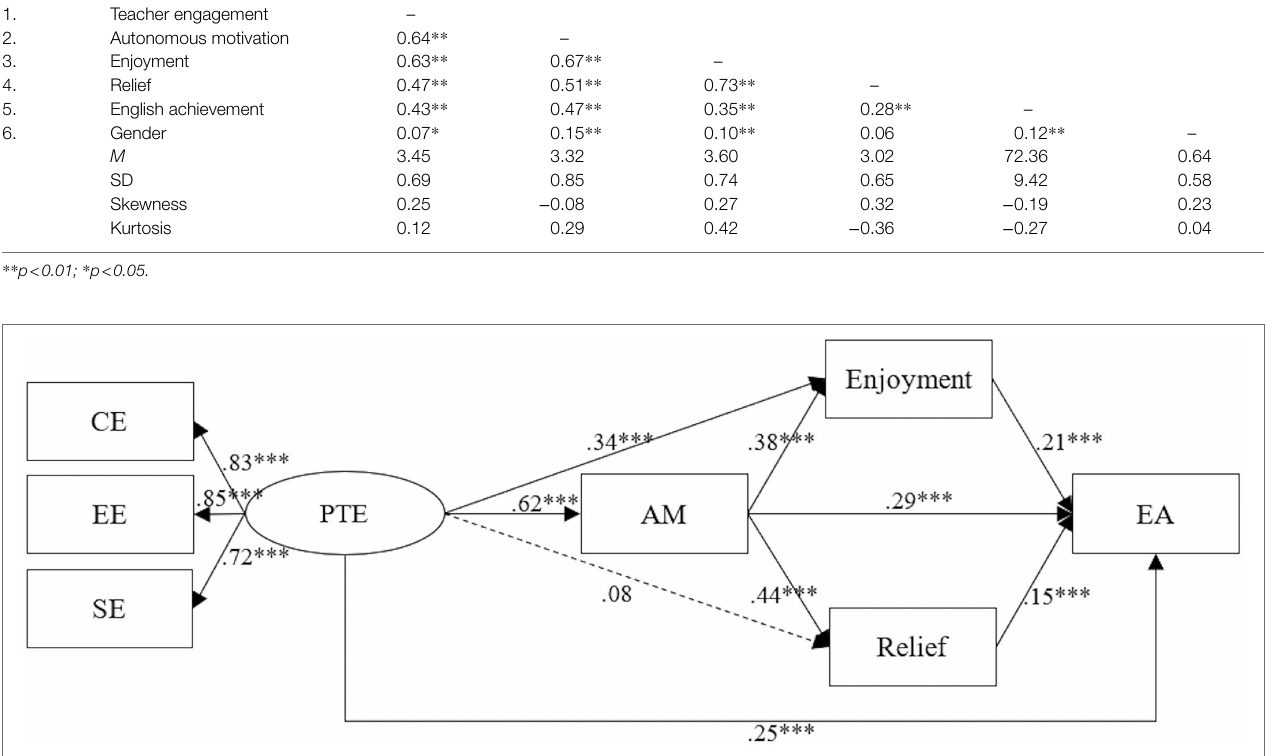
FIGURE 2 | Multiple mediating effects model. CE, Cognitive Engagement; EE, Emotional Engagement; SE, Social Engagement; PTE, Perceived Teacher Engagement; AM, Autonomous Motivation; EA, English Achievement. Coefficients shown are standardized path coefficients. *** p <